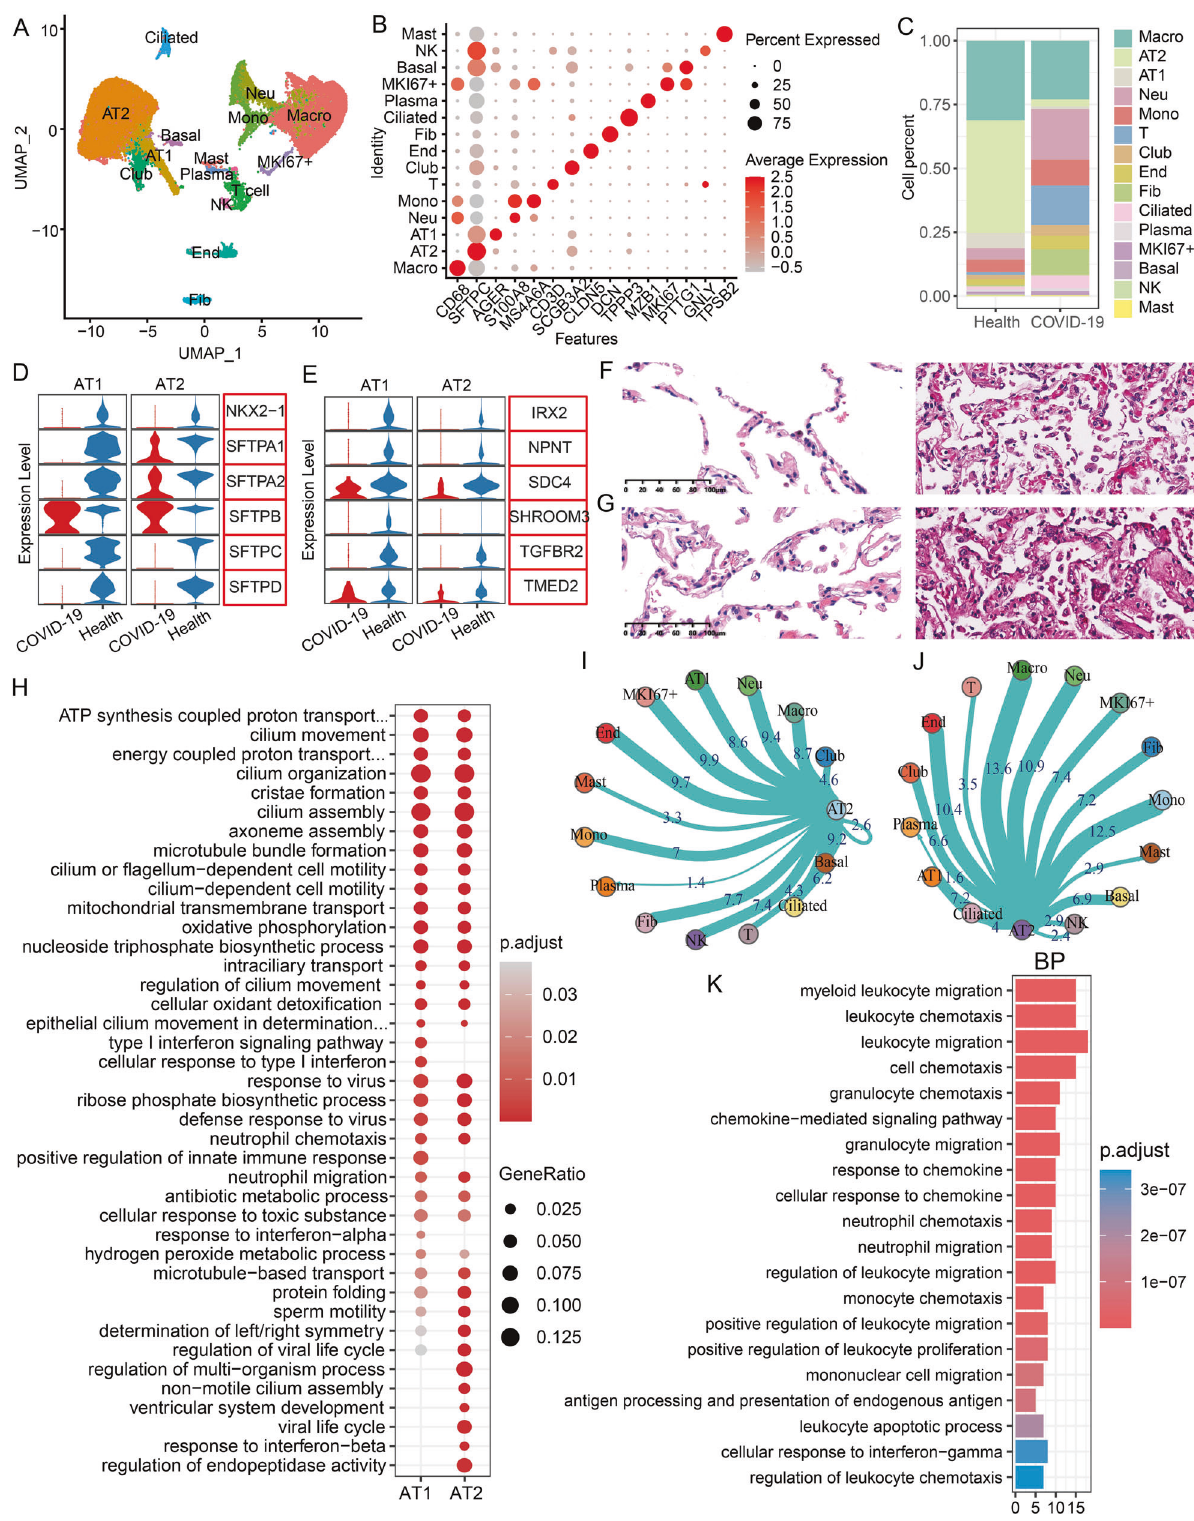
Fig. 2 Single-cell transcriptome analysis of the lung organs. A The UMAP cluster map shows the cell type clustering results of the lungs of healthy and COVID-19 patients. B The expression levels of classic marker genes corresponding to different cell types. C The proportion of different cell types in the healthy group and COVID-19 patients. D The expression levels of genes that regulate and maintain alveolar structure in the healthy group and COVID-19 patients. E The expression levels of genes that maintain epithelial cell homeostasis in the healthy group and COVID-19 patients. F , G HE staining of the lungs of age-matched control group and COVID-19 patients. On the left are two controls (C1, C2) and on the right are two dead patients (P1, P2). H Functional enrichment analysis of the biological processes involved in the differentially expressed genes in AT1/AT2 cells. I , J The frequency of cell communication between AT2 cells and other cell types in the healthy group and the COVID-19 group. K The biological process enrichment of signi fi cantly altered ligands and receptors in AT1/AT2 cells. Cell Death and Disease (2023)